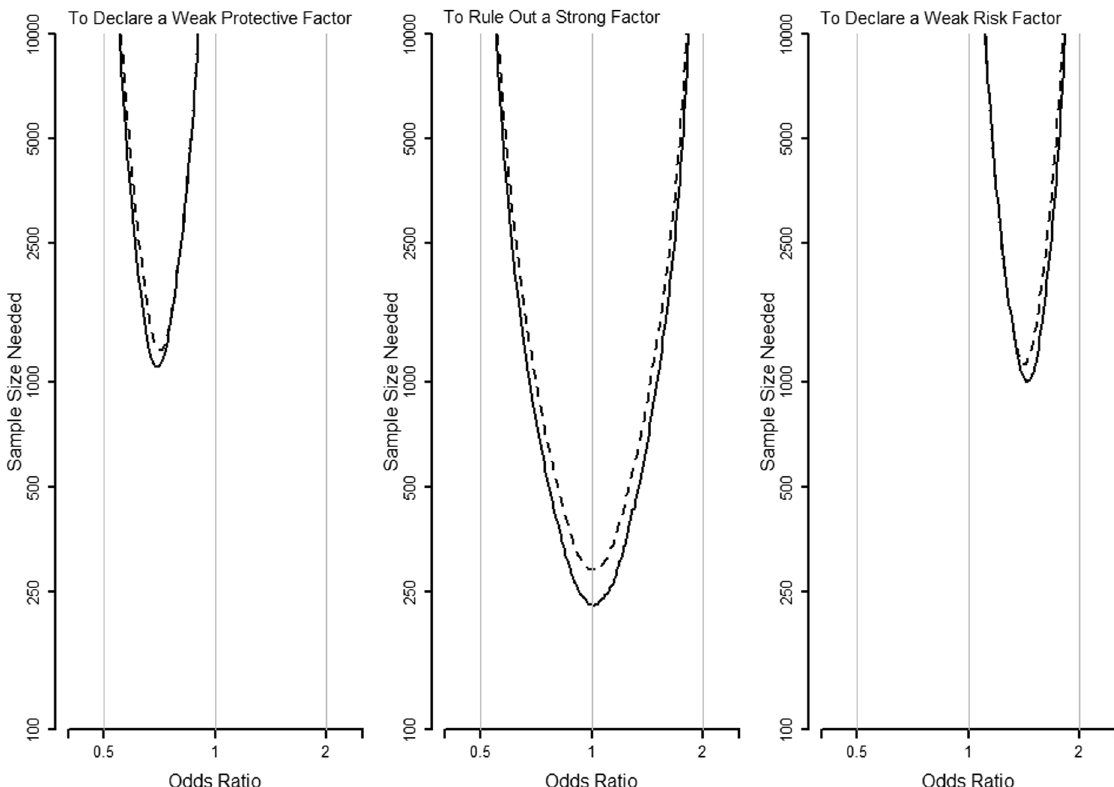
Figure 4. Sample sizes needed for the various conclusions (solid lines: the five-region method; dashed lines: the classical